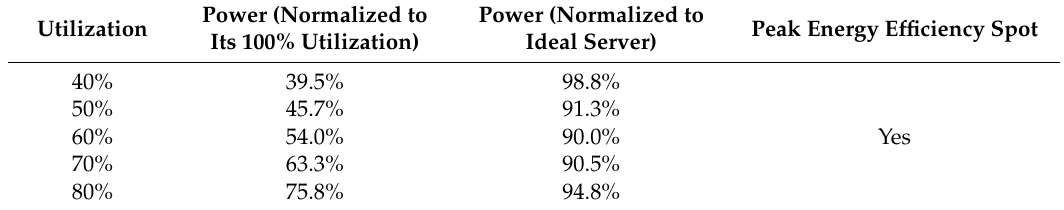
Figure 5. Typical EP curves of five real servers with peak energy efficiency at 100% and non-100% utilization. Table 4. More energy efficient working range of the server in Table 1.